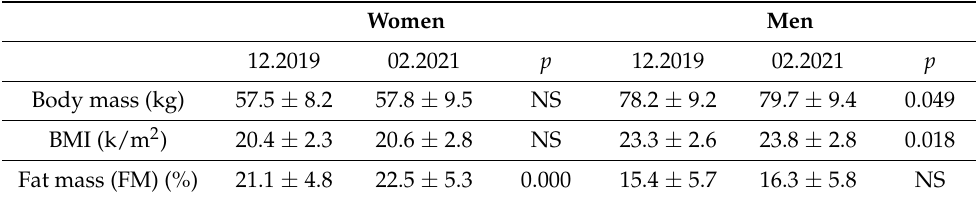
Table 2. Anthropometric measurements of the studied women and men .